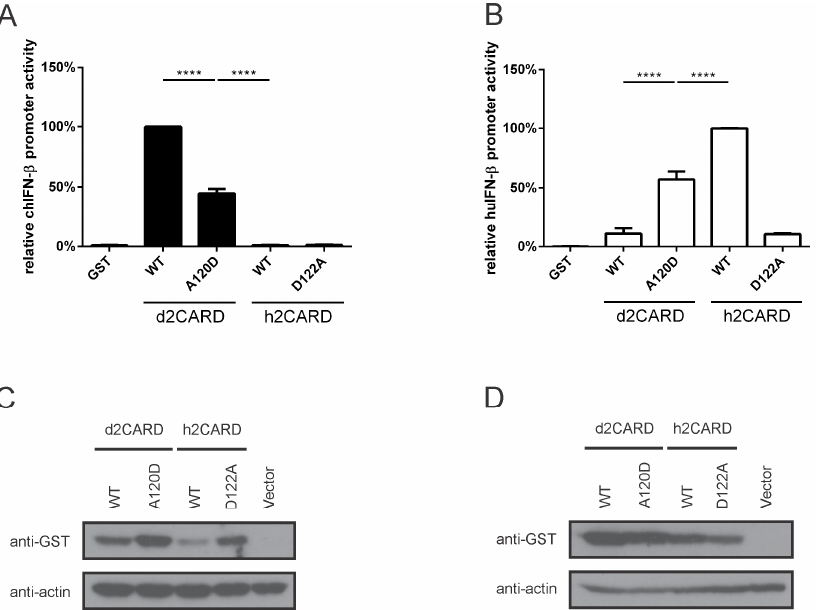
Figure 3. Amino acid residue 120 in duck RIG-I CARD domains (122 in human RIG-I-CARD) contributes to species-specific MAVS-CARD–RIG-I-CARD interactions. ( A ) d2CARD A120D mutation decreases IFN-β promoter activity in DF-1 cells, while h2CARD wild-type and the complementary D122A mutant remain inactive. ( B ) RIG-I d2CARD A120D mutant is more active than wild-type d2CARD in HEK293T cells, while the corresponding mutation in h2CARD nearly abrogates IFN-β promoter activity. Graph bars show mean ± SD of three independent experiments ( n = 3). Means were compared using one-way ANOVA with a Tukey’s multiple comparisons post-hoc test (****, p ≤ 0.0001). Total transfected DNA quantity was always kept constant with empty vector. ( C , D ) All GST-2CARD proteins are expressed in DF-1 cells ( C ) and HEK293T cells ( D ). Whole cell lysates were immunoblotted with anti-GST and anti-actin antibodies.